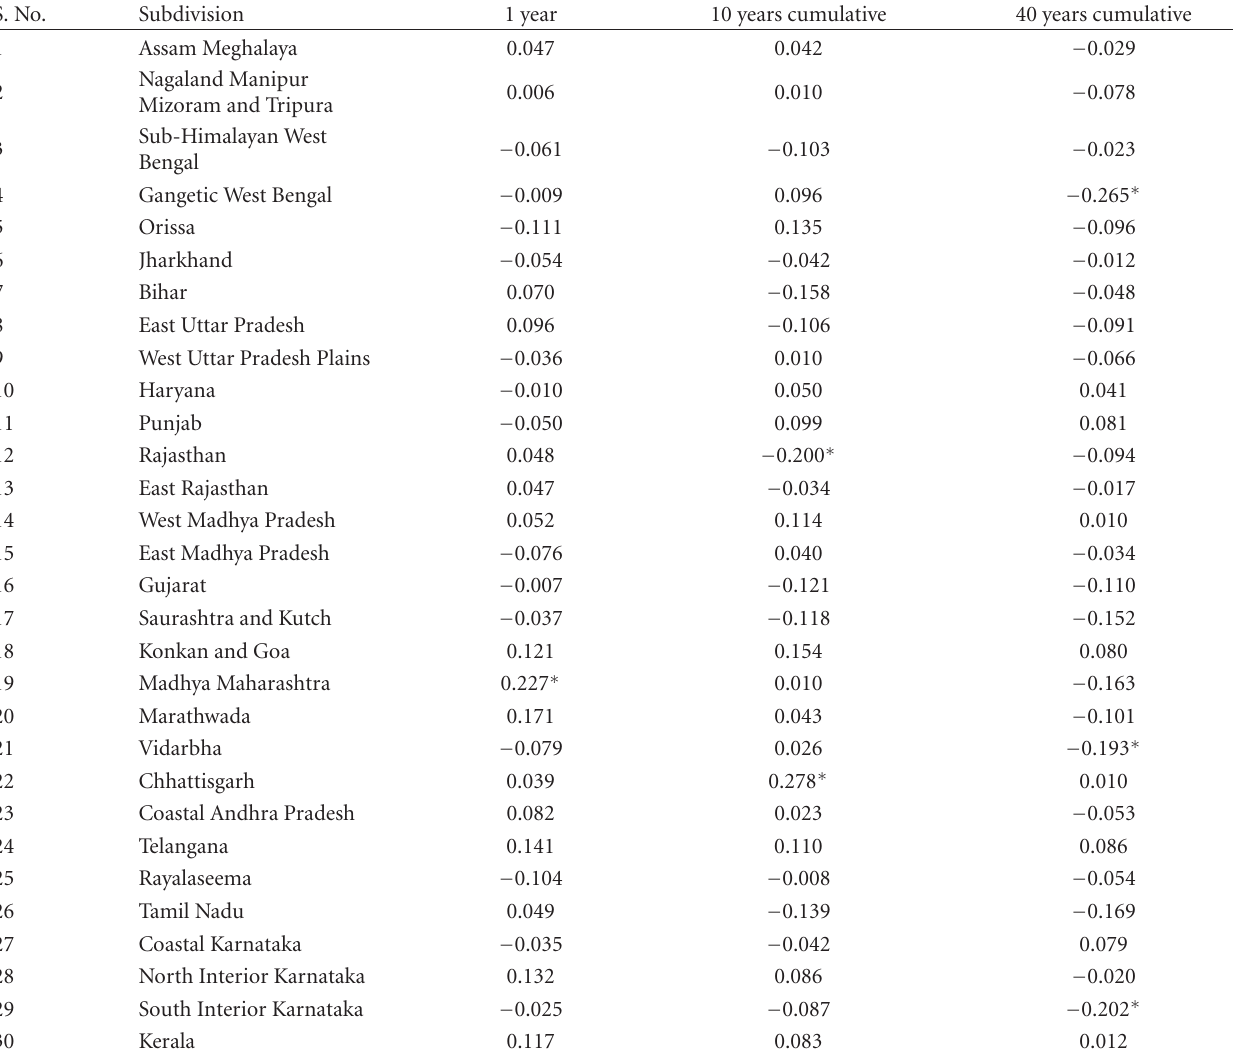
Table 1: Correlations of annual rainfall to that of the subsequent year, short-term (10 years), and long-term (40 years) cumulative: ∗ indicate significance of individual correlations at α = 0 . 05 level. Since a large number of statistical tests are being performed, a Bonferroni correction to the significance level is applicable. After the Bonferroni correction, none of the correlations are significant. S.